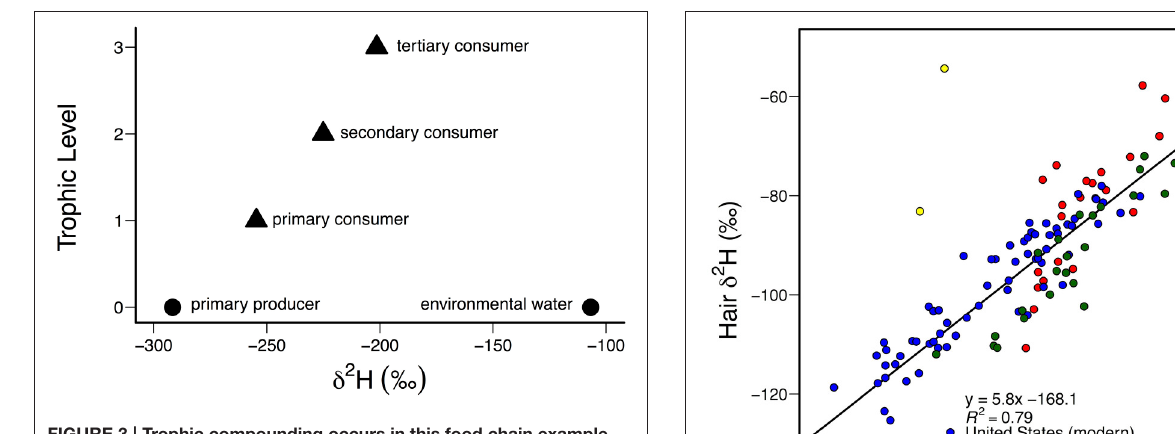
FIGURE 3 | Trophic compounding occurs in this food chain example consisting of three trophic levels. Each trophic level is assumed to consume from only the next lowest trophic level. The total contribution of environmental water to consumer tissue δ 2 H values depends on the value of ω compound and its trophic level, such that increasing contributions of environmental water to consumer tissue at each trophic level cause an increase in δ 2 H values. The value of ω was assumed to be constant at 0.2 in this example, while ω compound = 1 − (1– ω ) τ , and τ represents the trophic level. Aquatic primary producer ( − 291.6 ‰ , filamentous algae) and environmental water ( − 106.8 ‰ ) δ 2 H values used in this example are real measurements from the Colorado River ( Doucett et al., 2007). Values of δ 2 H were calculated using Equations (2) and (3) (see text).